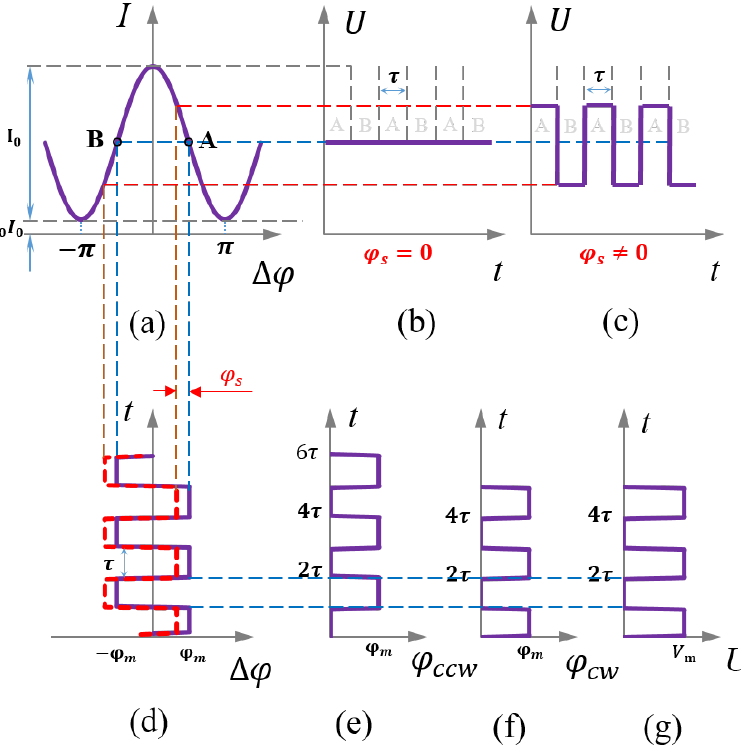
Figure 2. Square-wave bias modulation of a fiber-optic gyroscope. ( a ) Relationship between phase and light intensity, point “A” indicates that the bias phase is ϕ m , point “B” indicates that the bias phase is − ϕ m . ( b ) Light-intensity signal with zero rotational angular velocity. ( c ) Light-intensity signal with nonzero rotational angular velocity. ( d ) Phase difference of the two counter-rotating beams. ( e ) Modulated phase of the counterclockwise light. ( f ) Modulated phase of clockwise light. ( g ) Voltage applied with the phase modulator.